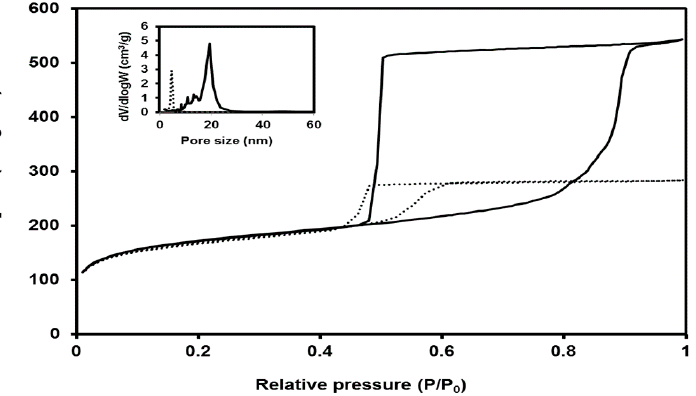
Figure 3. N 2 adsorption–desorption isotherms of an m-MCF material, its pore size distributions (insert; full line), and the original plugged SBA-15 (dotted line), which were synthesized at 70 °C 3 days [29].